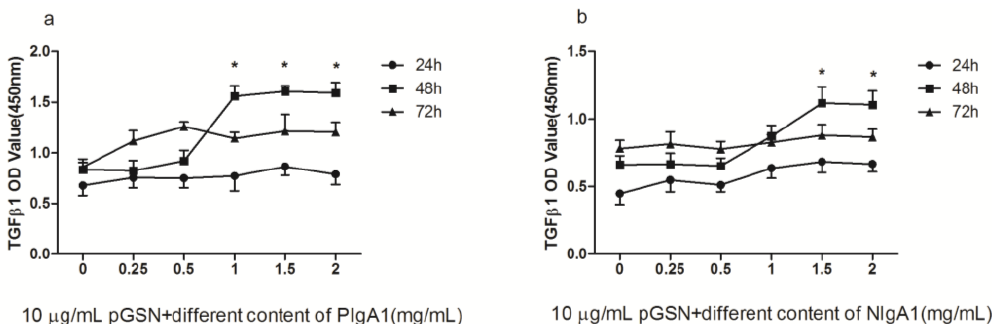
Figure 3. The comparison of TGF-β1 secretion by HMCs which stimulated with pGSN and different content IgA1 (PIgA1 and NIgA1). ( a ) PIgA1 treatment: the TGF-β1 secretion has a peak when HMC cultured with 10 µg/mL pGSN and 1–2 mg/mL IgA1 from IgA patients (PIgA1) in 48 h; ( b ) NIgA1 treatment: the TGF-β1 secretion has a peak when HMCs cultured with 10 µg/mL pGSN and 1.5 mg/mL IgA1 from healthy (NIgA1) in 48 h. Each sample in this experiment containsthree repeated data ( n = 3), the between-group differences were calculated with a one-way ANOVA and LSD test, and the results are presented as means ± standard deviation (SD).